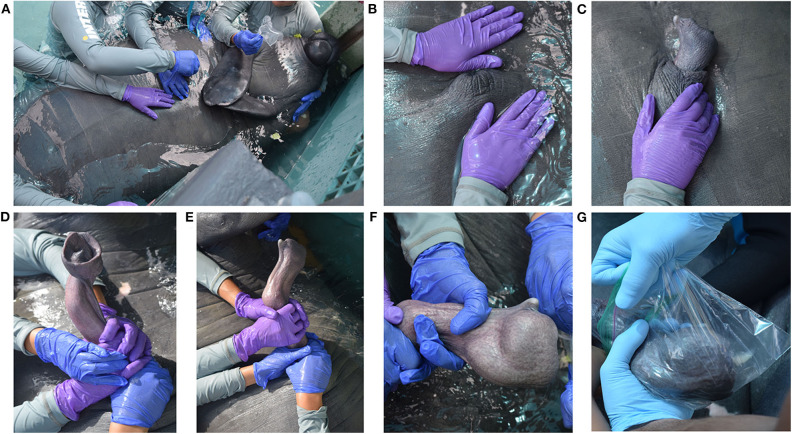
Manual semen collection in a captive male West Indian manatee. (A) The male is positioned at the edge of the pool with his ventral side above the water and his body supported by in-water trainers. (B,C) The male receives tactile stimulation to the genital region until partial extrusion or a full erection is achieved. Tactile stimulation is focused on the mid-shaft region and glans penis to elicit the best stimulatory response. (D,E) The penis enters a pre-ejaculatory state characterized by the formation of a penile cup at the distal end of the penis and a bulbis glandis along the midshaft of the penis. (F) The penile cup becomes increasingly engorged as the male approaches ejaculation. (G) Upon ejaculation, semen is collected into a clear plastic bag for immediate processing and analysis.